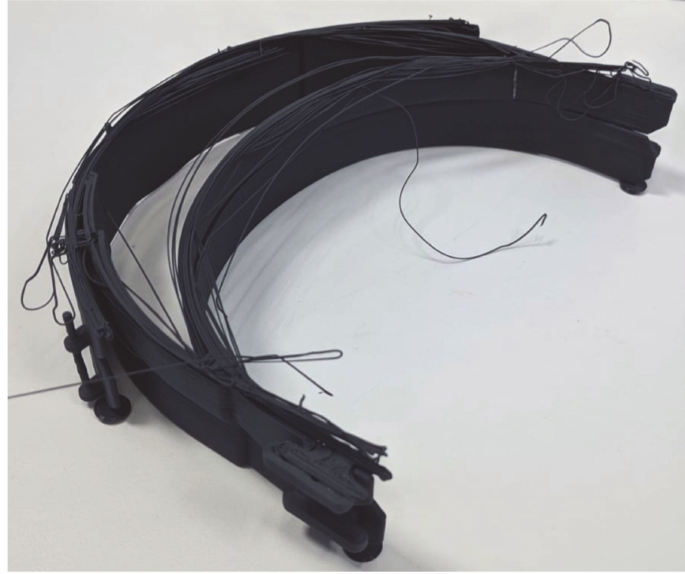
Figure 5. Insu ffi cient adhesion between layers on a part made from polylactic acid